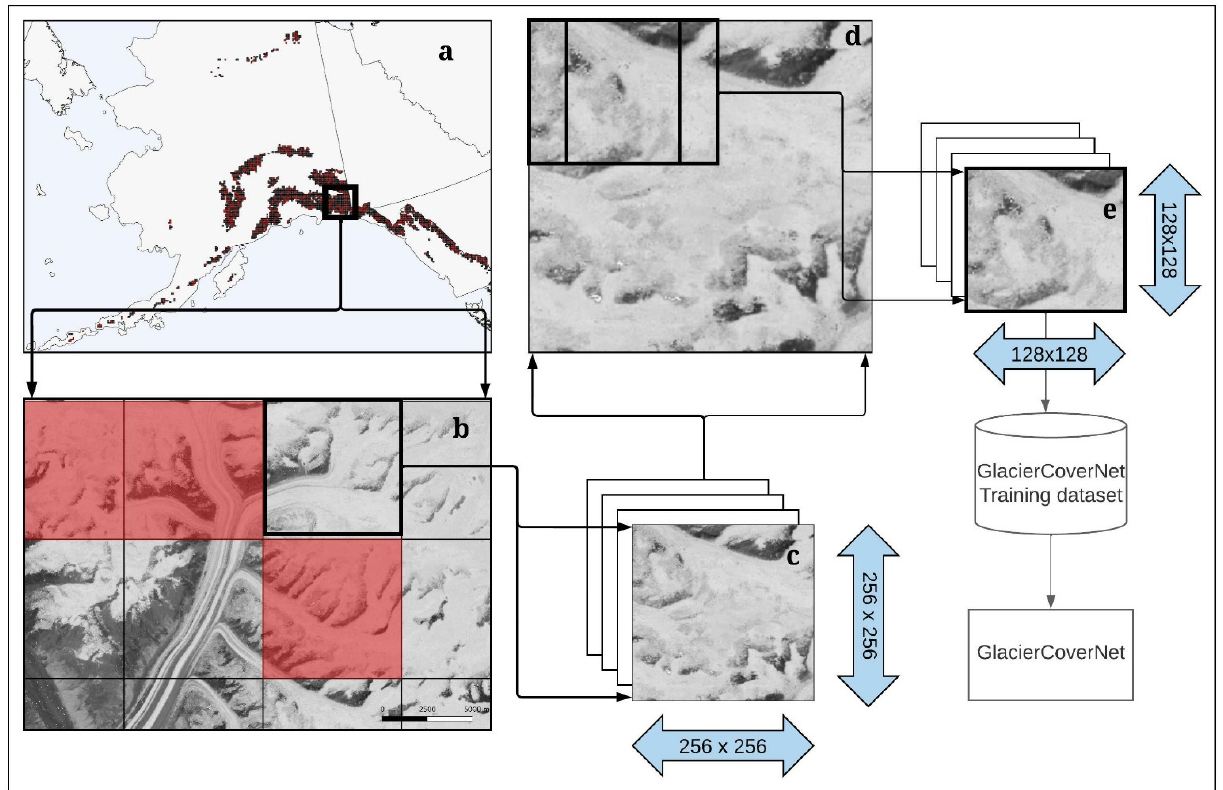
Figure 3. Training data generation. ( a ) Study area partitioned into 20% testing (red) and 80% training (black), ( b ) zoom of partitioned area with testing (red) and training (black outline), ( c ) 10-band 256 × 256 image partition, ( d ) moving window sampling process, and ( e ) final 128 × 128 image chips used for GlacierCoverNet model training and testing. Note that this is a conceptual diagram and is therefore not to scale.